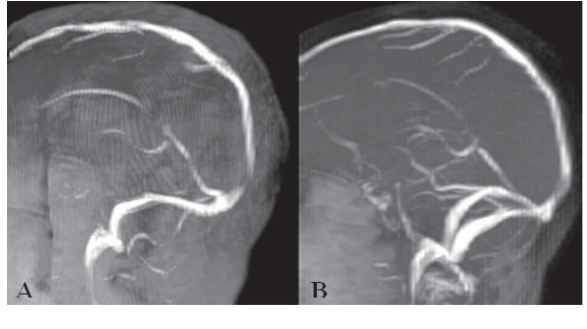
Figure 1. MRV showing Superior sagittal sinus, inferior sagittal sinus, straight sinus, vein of Galen, internal cerebral vein